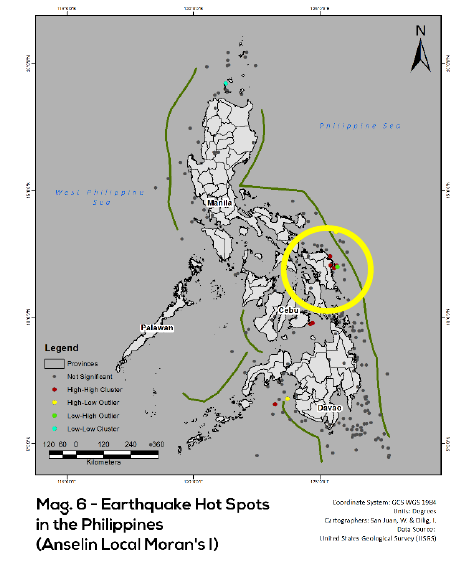
Figure 12. Mag.6-Earthquake Clusters in the Philippines